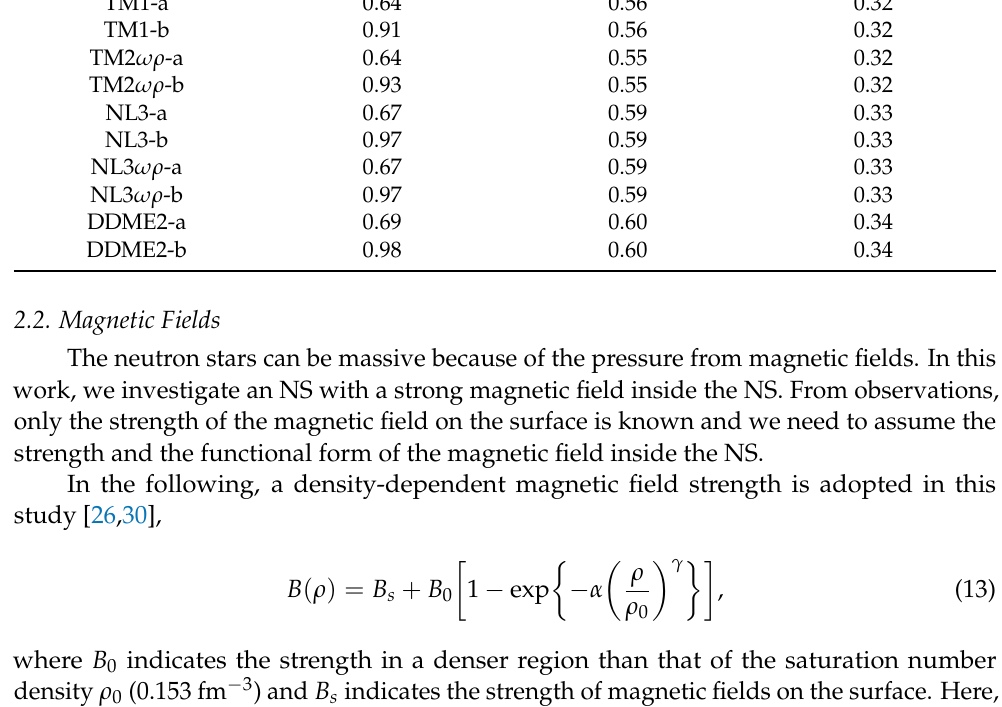
Table 2. Adopted ratios of σ - Λ coupling, σ - Σ coupling, and σ - Ξ coupling in EoS parameter sets. EoS R σ Λ R σ Σ R σ